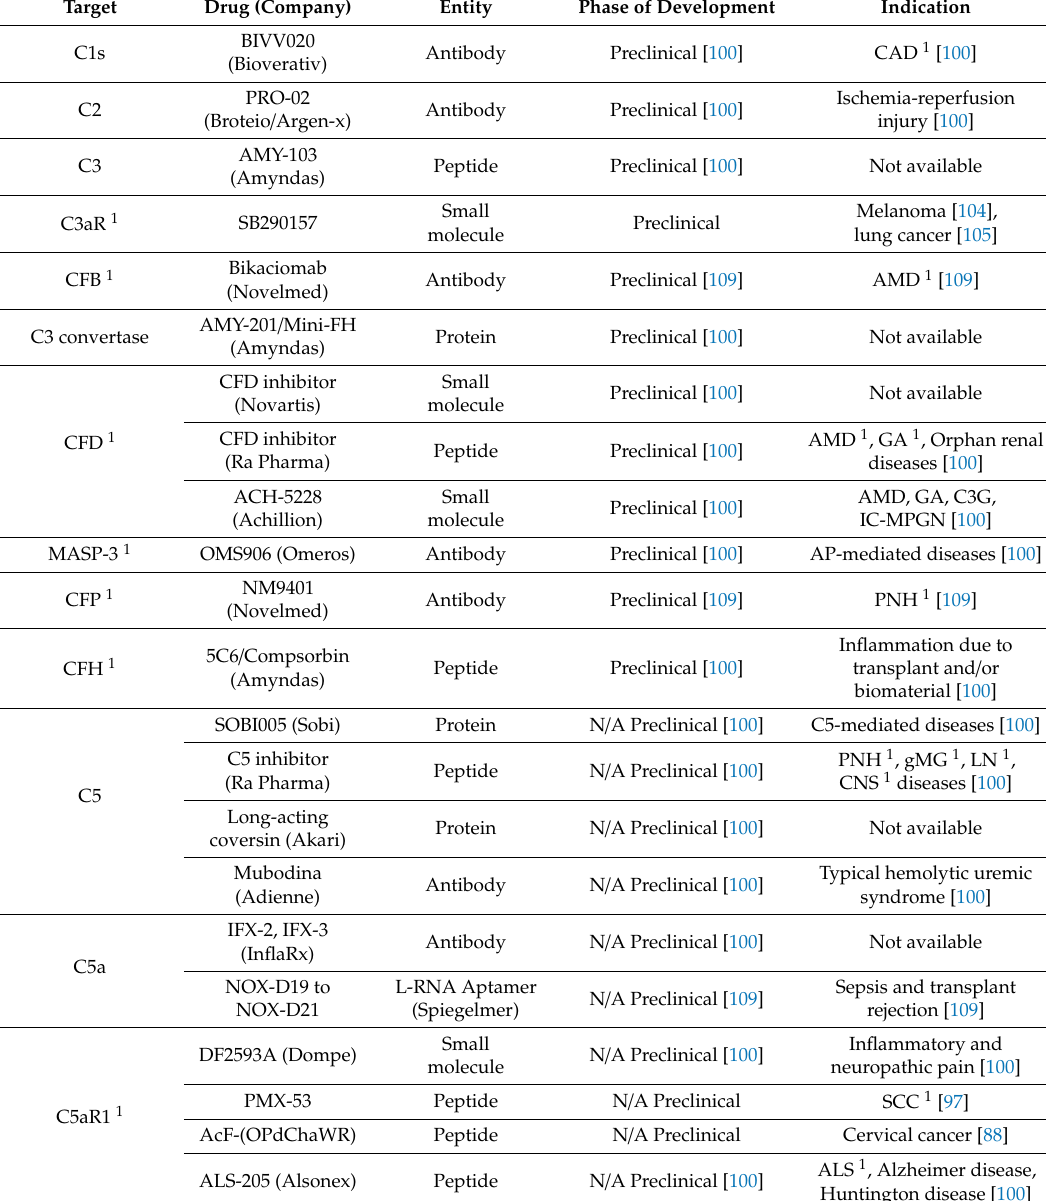
Table 2. Complement-targeted therapeutic molecules in the preclinical phase of drug